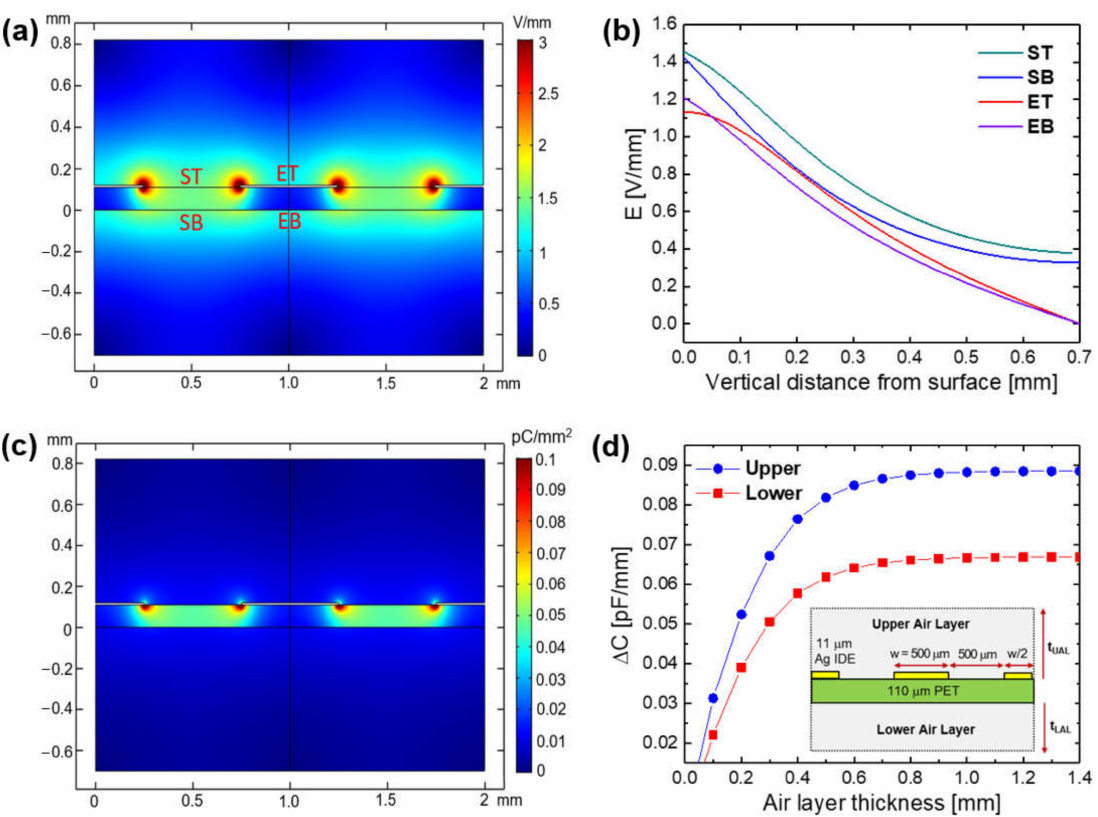
Figure 3. For the unit cell of capacitive sensor with 1 pair of IDEs on PET substrate in air: ( a ) the distribution of fringing electric field (FEF), ( b ) the FEF strength with the vertical distance from the sensor surfaces in different regions (ST, SB, ET, and EB), ( c ) the distribution of electric displacement field, and ( d ) the capacitance of air capacitor with the air layer thickness (blue: upper air capacitor, red: lower air